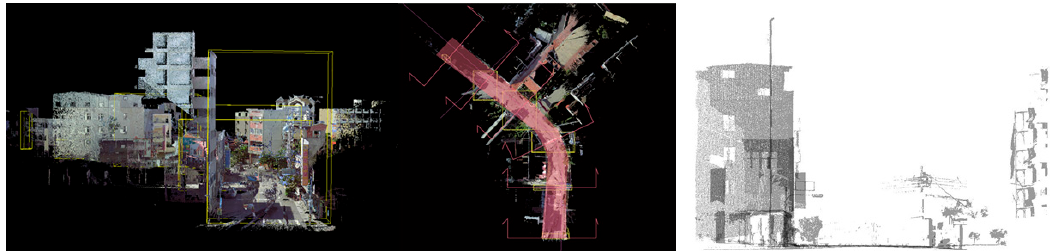
Figure 2. Street block with thick sections sliced along the central line.